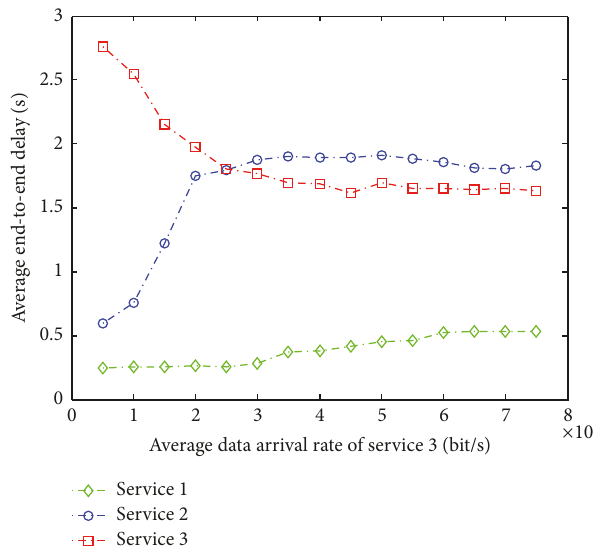
Figure 10: Comparison of average end-to-end delay in multihop